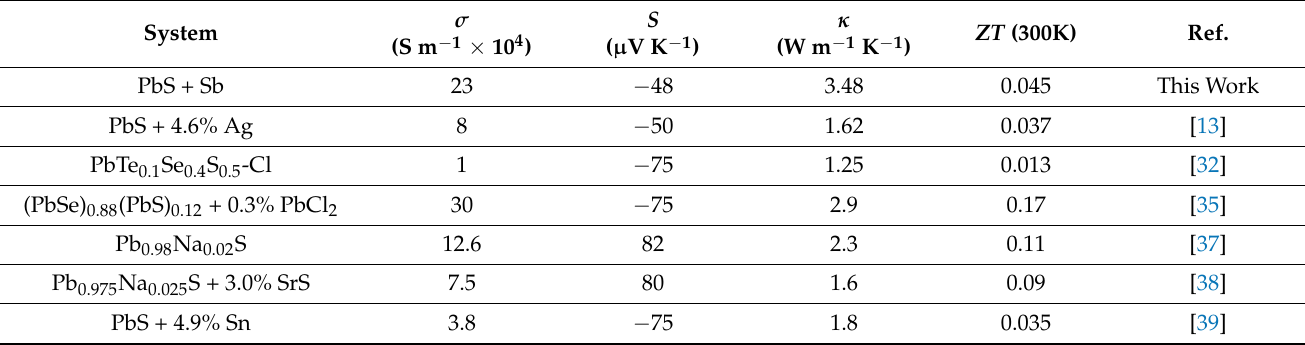
Finally, Table 2 shows the state-of-the-art values of ZT for lead chalcogenide com- pounds doped with different elements for reference. Table 2. State of the art of ZT values for lead chalcogenides compounds doped or mixed with different elements. System